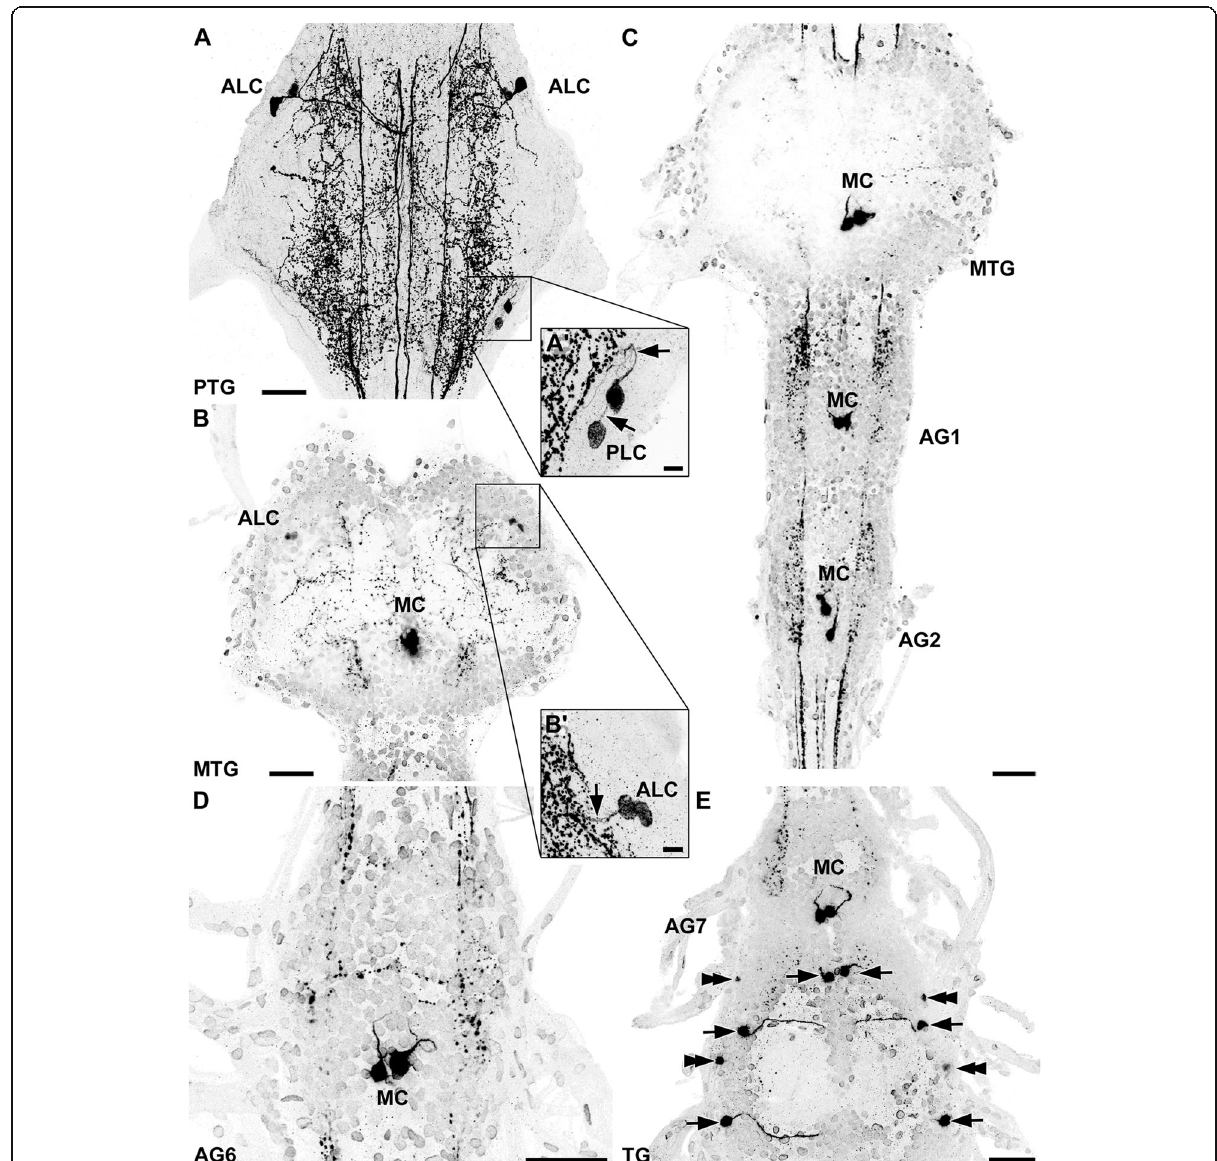
Fig. 1 Distribution of histaminergic cells in the ventral nerve cord of Thermobia domestica . Maximum projections of cLSM stacks (ventral view, anterior to the top). a The prothoracic ganglion (PTG) contained up to three anterolateral (ALC) and two posterolateral cell bodies (PLC). a ’ The PLC showed a short anterior projection pattern (black arrows). b Additionally to the ALC, a pair of medial cell bodies (MC) could be identified in the metathoracic ganglion (MTG). b ’ The ALC projected in medial direction (black arrow), although the neurites could only be traced for a short distance. c, d Every ganglion except for the PTG possessed a pair of MC. e In the terminal ganglion (TG), three pairs of consistently labeled neurons (black arrows) and two additional faintly labeled somata groups (black double arrowheads) could be identified. Abbreviations: AG1 – 7: abdominal ganglia 1 – 7; ALC: anterolateral cell bodies; MC: medial cell bodies; MTG: metathoracic ganglion; PLC: posterolateral cell bodies; PTG: prothoracic ganglion; TG: terminal ganglion. Scale bars: a – e: 50 μ m; a ’ , b ’ : 10 μ